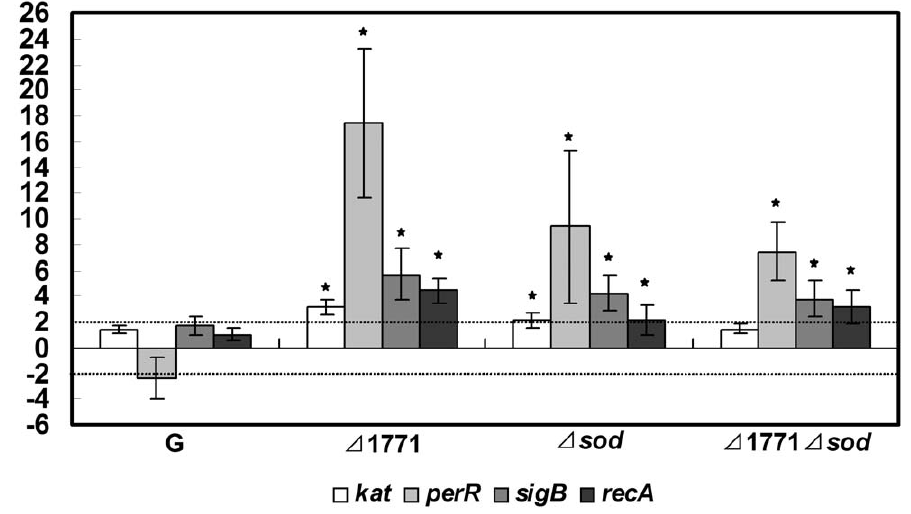
Figure 6. Expression of four oxidative stress-related genes in biofilms of different L.monocytogenes strains. 3-day planktonic cells from different strains grown statically were used as standards. Data shown are mean values with standard deviations (n $ 6). Stars ( w ) indicate that fold- changes were significantly different ( p -value , 0.05).